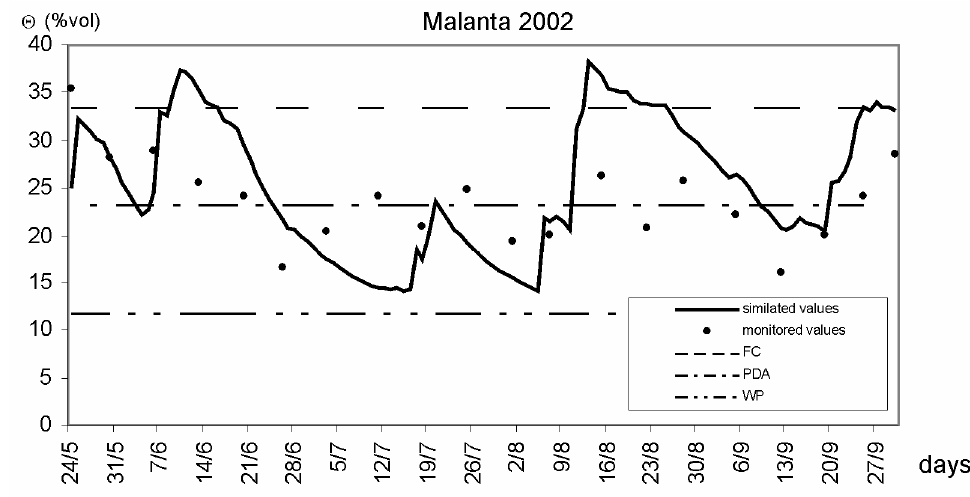
Fig 4. Measured and simulated values of volumetric soil water content in study area of Malanta in 2002